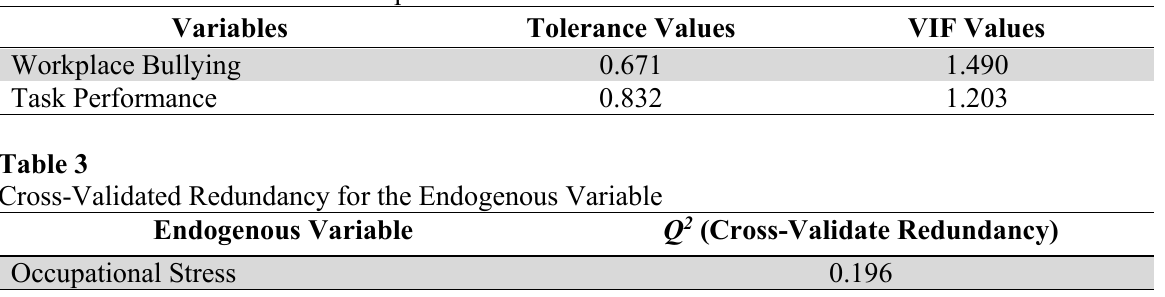
Tolerance and VIF Values for Independent and Outcomes Variables